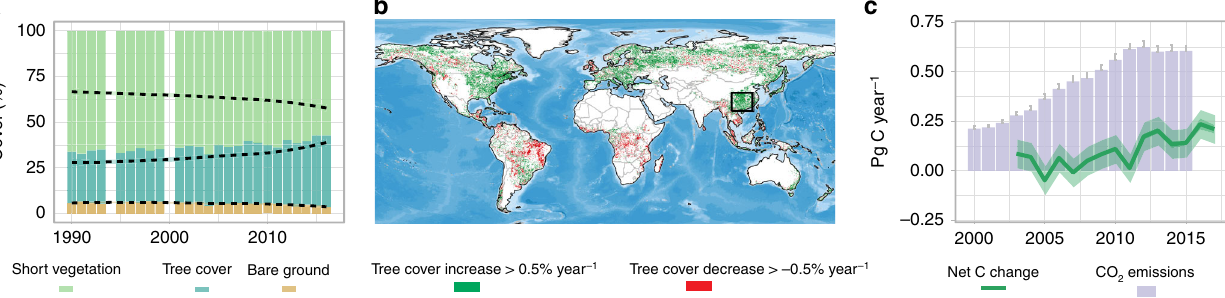
Fig. 1 Dynamics in forests and carbon stocks in southern China. a AVHRR estimated 27 dynamics in tree cover, and cover fraction of short vegetation, which is grass and cropland, as well as bare ground from 1990 to 2016 in southern China. b The same data source is used to show global increases and decreases in tree cover (larger 0.5% year − 1 ) from 2000 to 2016. The study region is marked with a black rectangle. c Fossil CO 2 emissions (2000 – 2015) 30 from the eight provinces in southern China (error bars are standard deviations) compared to net C changes (2002 – 2017) in aboveground vegetation calculated from MODIS data for the same area (shaded area is the uncertainty based on the RMSE between MODIS- and SMOS-based estimates; see text). Pixel number for eight provinces = 8,573,649. Source data are provided as a Source Data fi